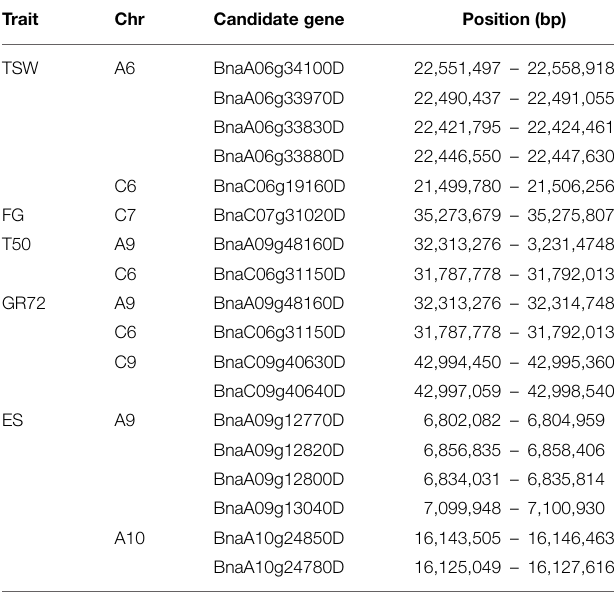
TABLE 4 | List of candidate genes ascribed to seed germination, dormancy and seed development: Chromosome (Chr), Name of the candidate gene (Candidate gene) and absolute chromosomal position in base pairs [Position (bp)].